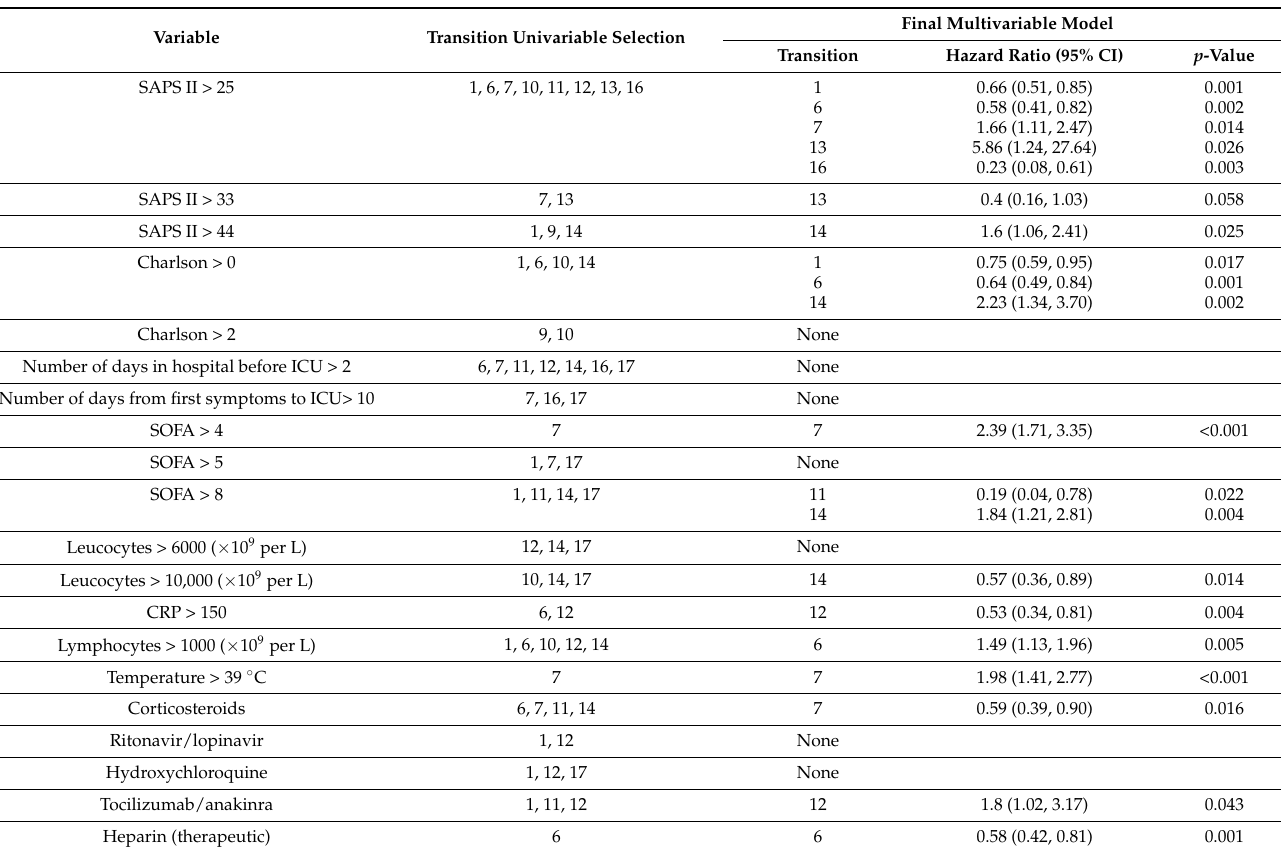
Stacked probabilities of state occupancy resulting from the G-computation “approach” for corticosteroid and IL-antagonists are displayed in Figure S1 (Supplementary Material). The marginal difference in the probability of death at day 60 was 6.1% (95% CI: